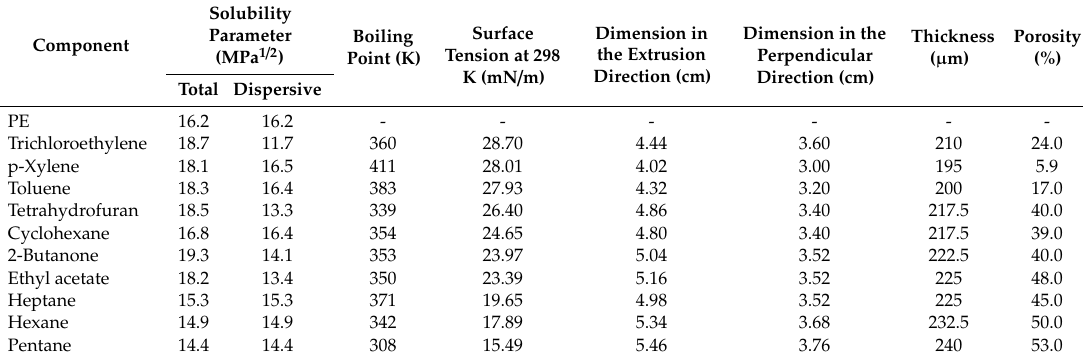
Table 4. Membrane dimensions using 10 extractants to remove the diluent and produce microporous PE membranes